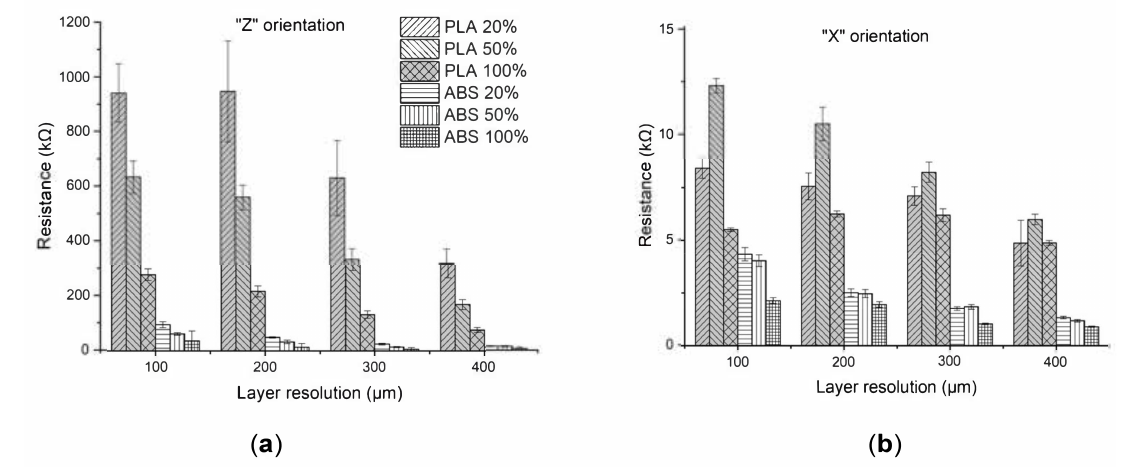
Figure 3. The e ff ect of infill density on electrical resistance. The test bars indicate the average resistance values with the standard deviation. On the left ( a ), the results of the Z printing orientation, and on the right ( b ), the results of the X printing orientation are demonstrated.